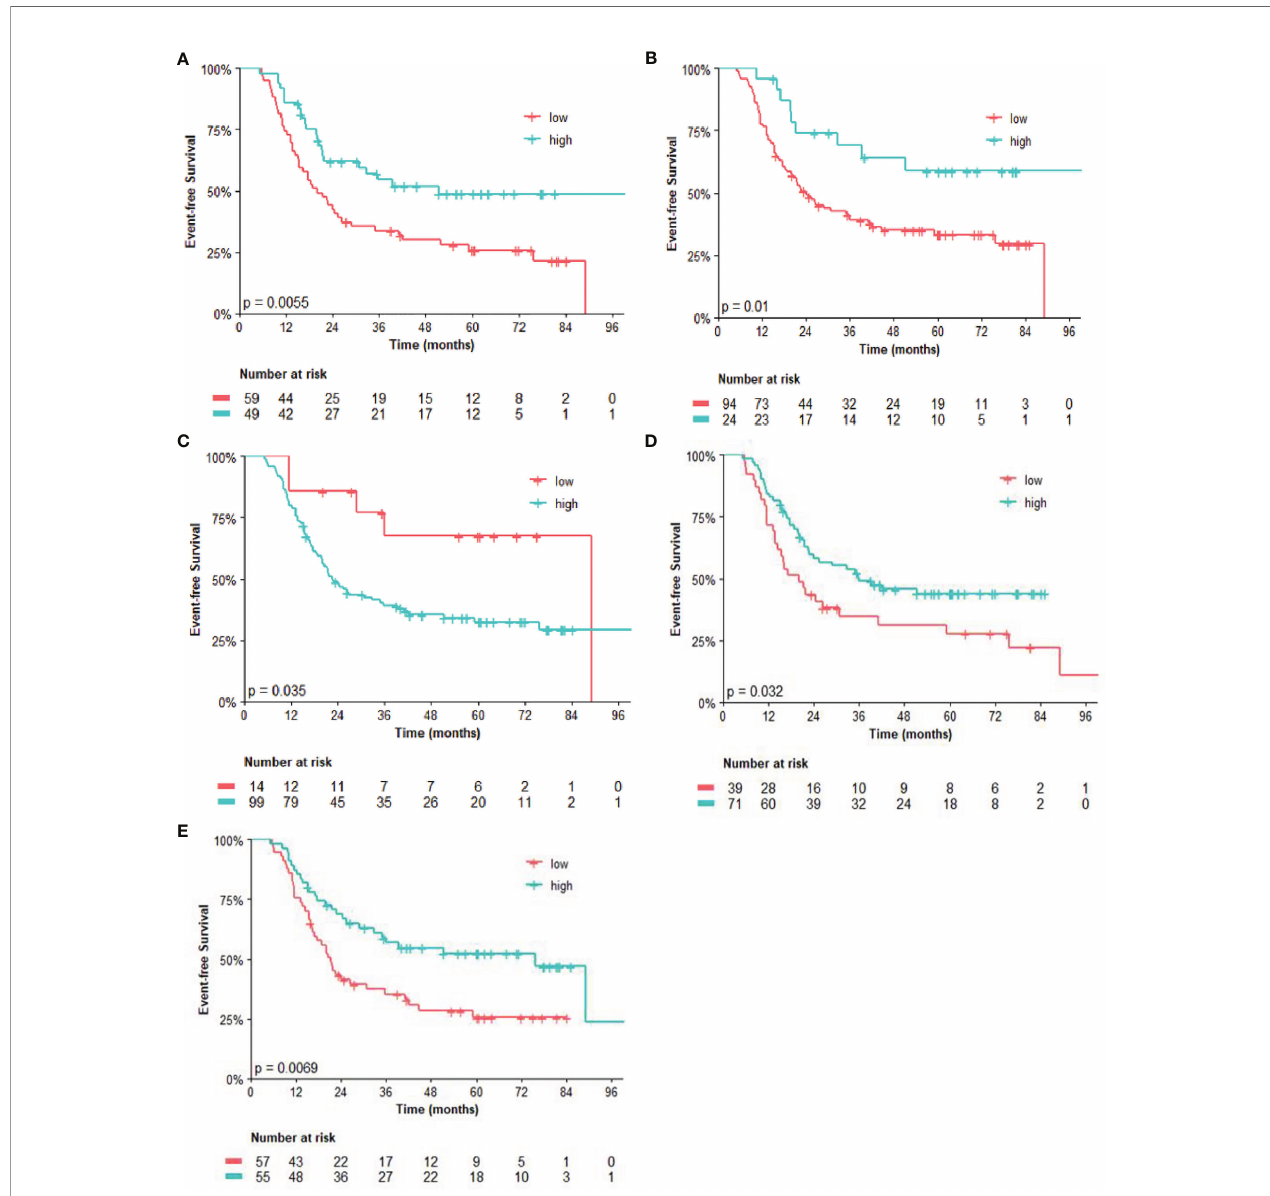
FIGURE 2 | Event-free survival (EFS) by (A) CD3; (B) CD8; (C) CD14; (D) CD4/FOXP3 ratio; and (E) CD8/FOXP3 ratio. Regarding the immunohistochemistry markers and the ratios, Kaplan – Meier curves for EFS were strati fi ed according to the cutoff for prognostic evaluation and divided into low versus high subgroup for each variable subsets. The red solid line indicates patients with low values and the blue solid line indicates patients with high values. Tick marks indicate censored